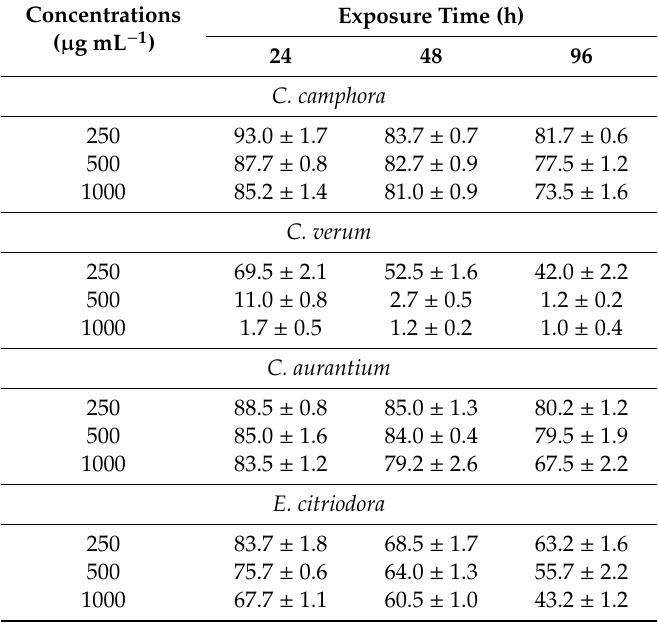
Table 3. Percentage hatchability (means of four replicates ± SE) of M. incognita eggs after 24, 48 or 96 h exposure of egg masses to 125–1000 µ g mL − 1 solutions of the ten tested